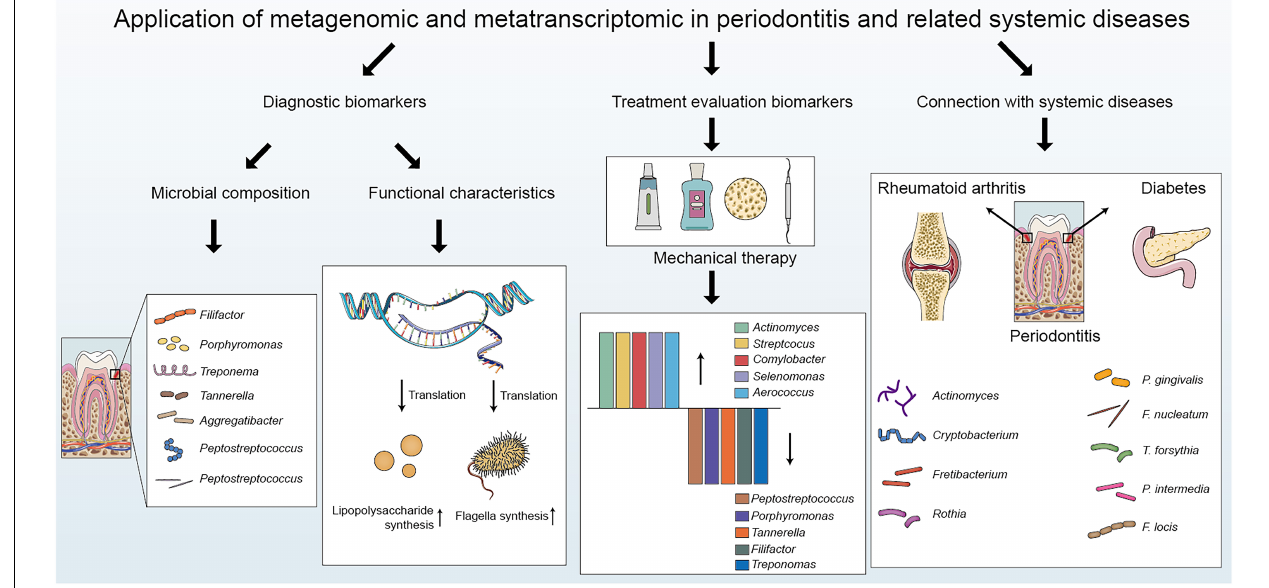
FIGURE 2 | The applications of metagenomics and metatranscriptomics in periodontitis: biomarker detection, treatment evaluation and connection with periodontitis-related systemic